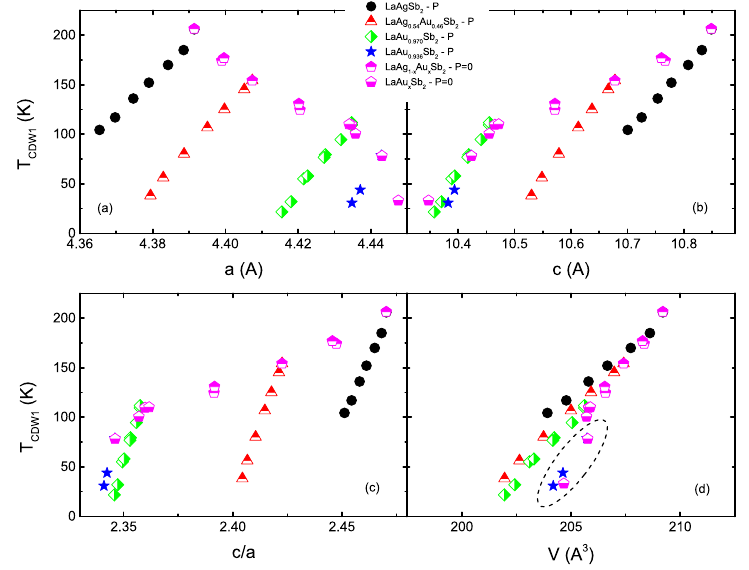
Figure 11. CDW1 transition temperature for LaAg 1 − x Au x Sb 2 and LaAu x Sb 2 [17] at ambient and high pressure as a function of ( a ) a ; ( b ) c ; ( c ) c / a ; and ( d ) V structural parameters. Encircled points discussed in the text.